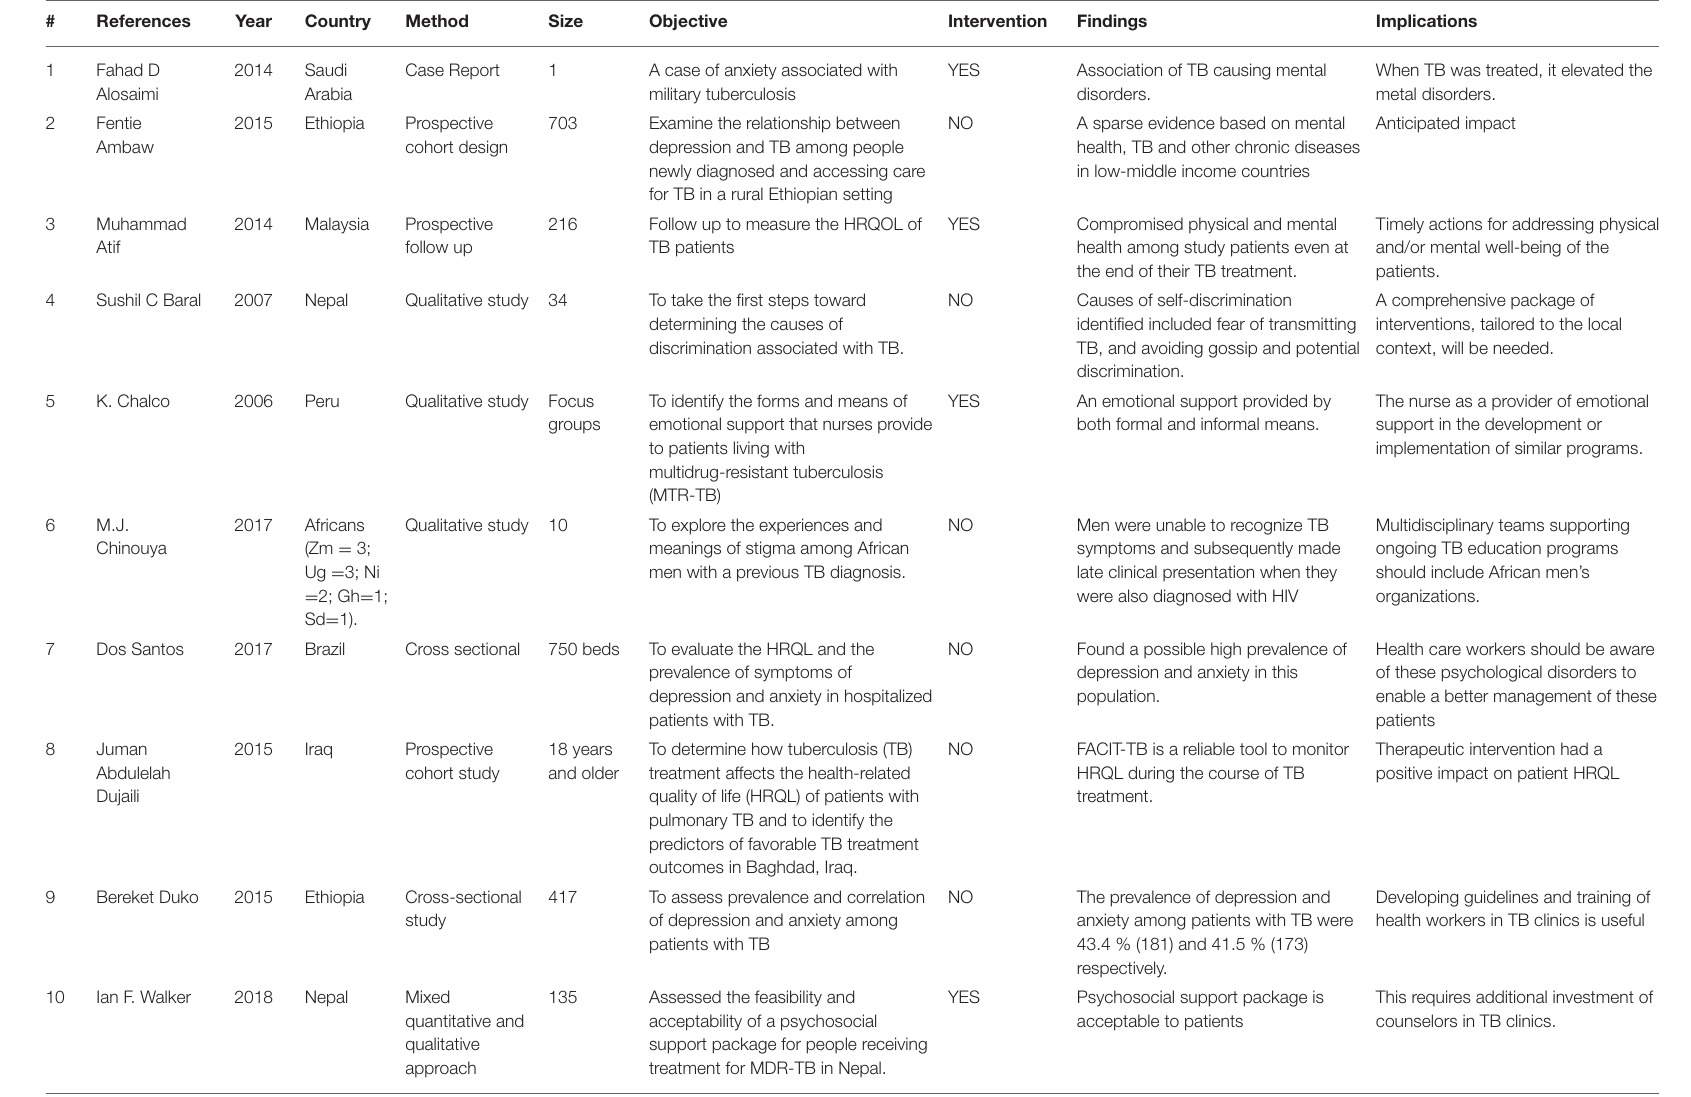
TABLE 1 | Data extraction